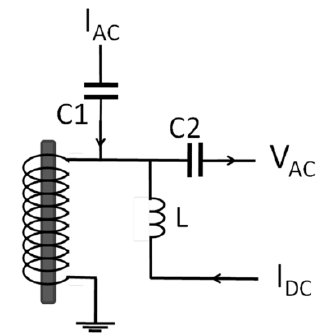
Figure 1. Configuration of the magnetic